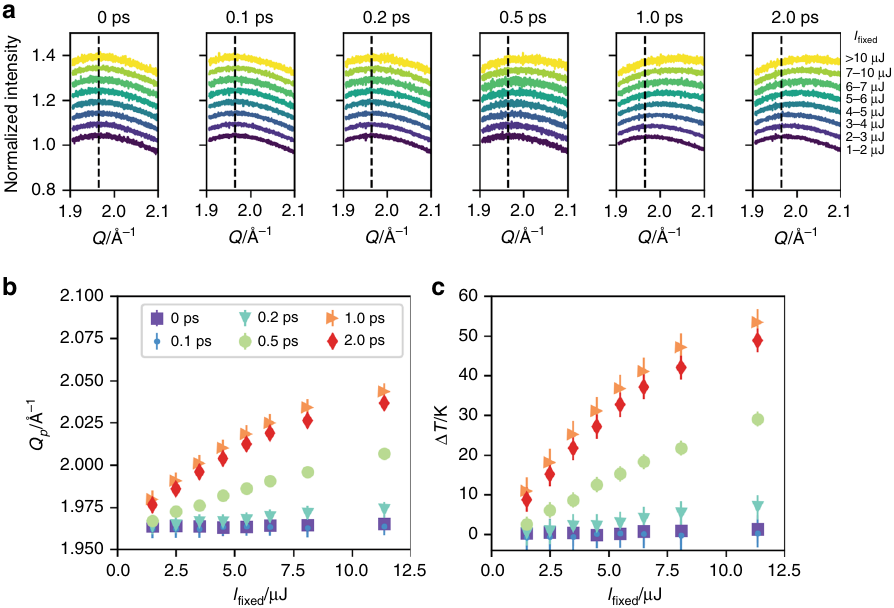
Fig. 4 Dependence of scattering intensity pro fi les on the pulse energy of the fi xed-delay branch. a Normalized scattering intensity around Q = 2 Å − 1 . The delay time between two sub-pulses Δ t is shown at the top of the panels. The pulse energy of the fi xed-delay branch I fi xed is shown on the right. The pro fi les are vertically shifted for the sake of clarity. The dashed lines show the peak position when Δ t = 0 and 1 µ J < I fi xed < 2 µ J. b Dependence of the peak position Q p on I fi xed . Δ t is shown as the legend. c Estimated values of the temperature rise due to the sub-pulse from the fi xed-delay branch. The error bars were determined by the standard deviation of the fi tting of the peak